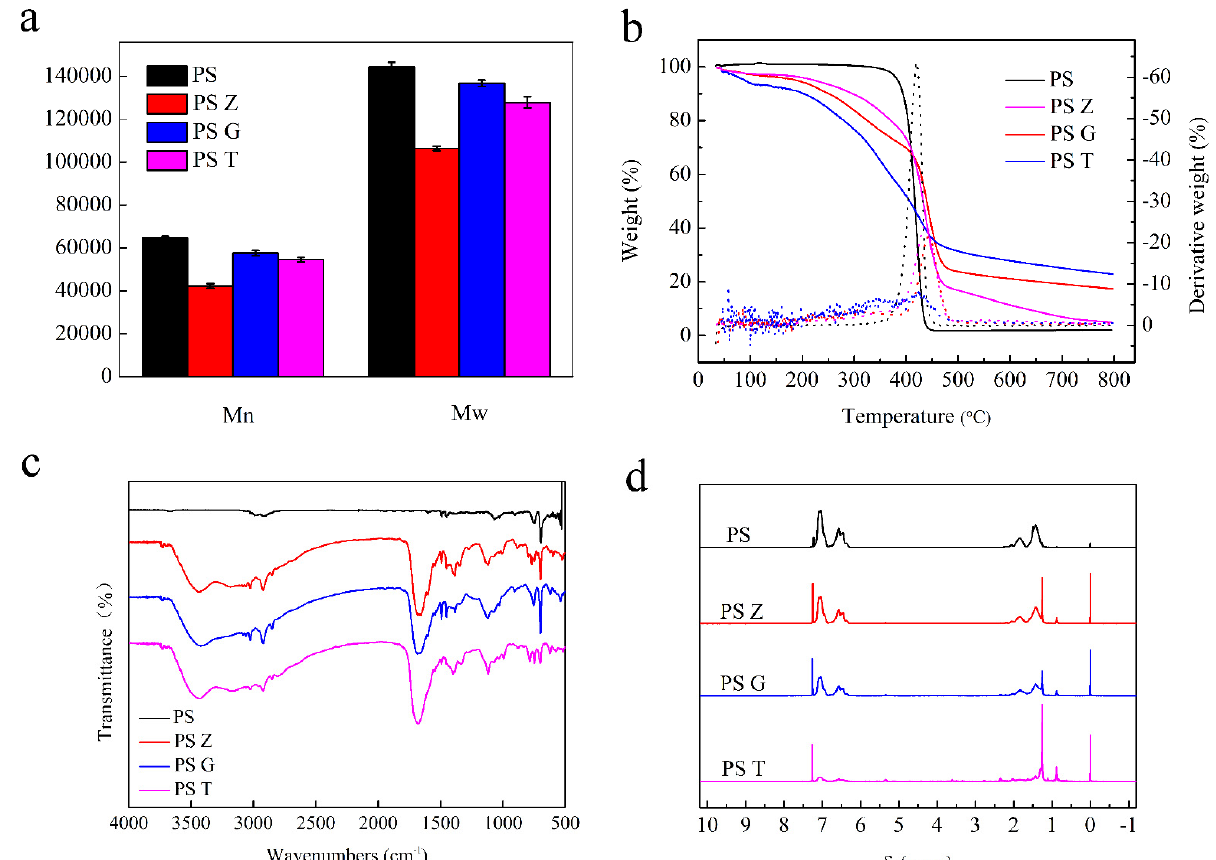
Figure 2. Depolymerization of PS by the three species’ larvae. Comparison of the Mn and Mw of PS and polymers extracted from frass ( a ), the TGA spectra of the PS and frass of PS-fed larvae ( b ), the FTIR spectra of the PS and frass of PS-fed larvae ( c ), and the 1 H-NMR spectra for the PS and frass of larvae fed with PS only ( d ). Z: superworms, G: greater wax moths, T: yellow mealworms.